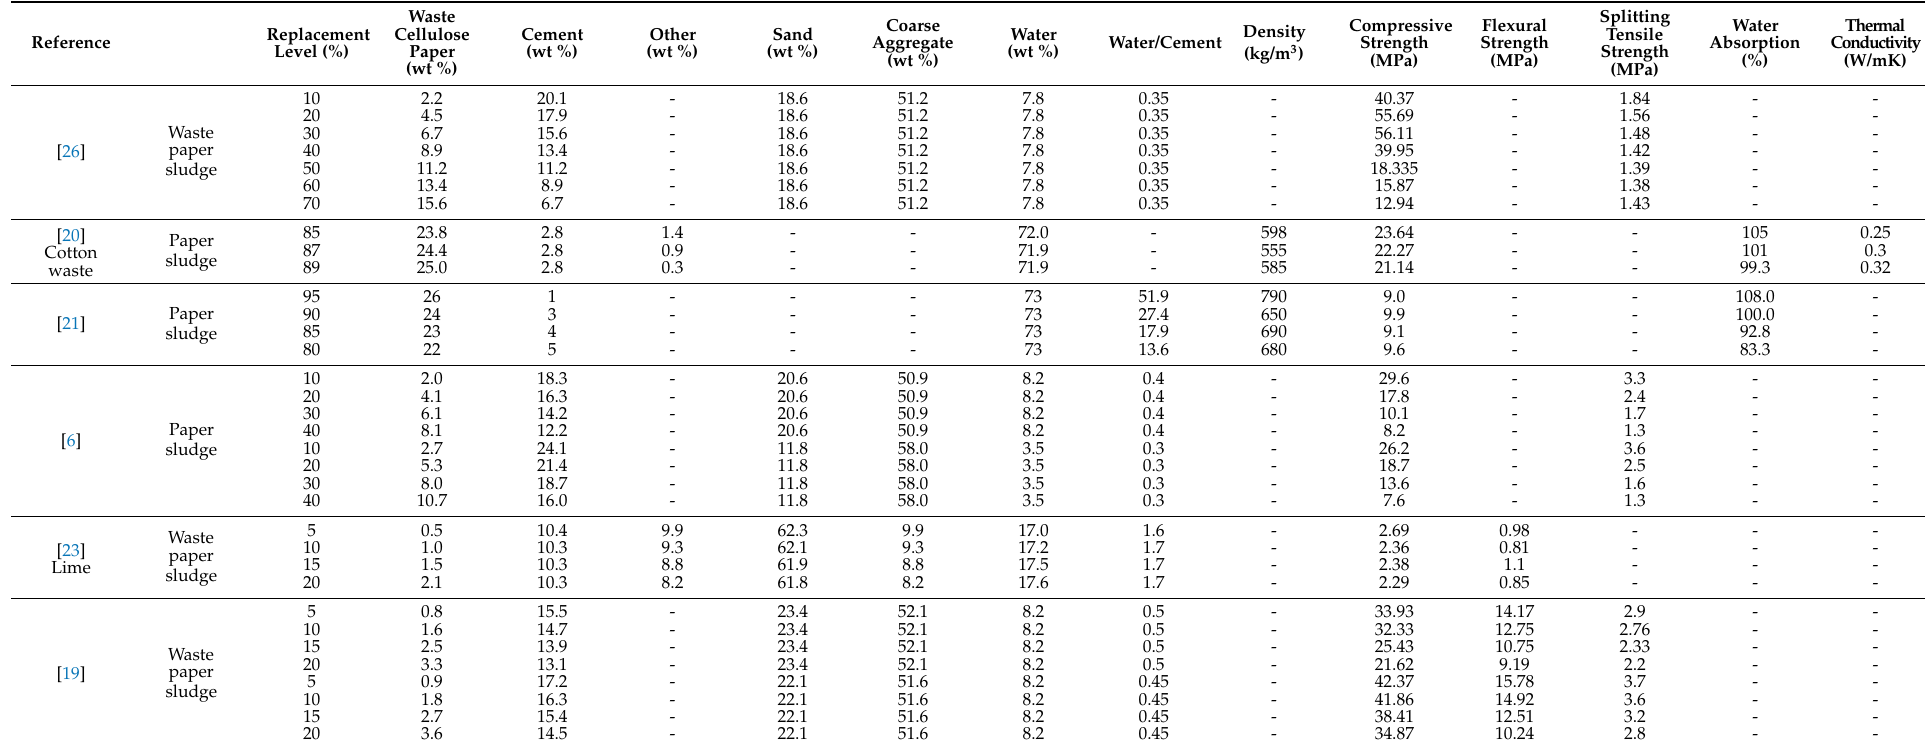
Table 4. Mix design and performance of cellulose waste (waste paper and cardboard) cement-based